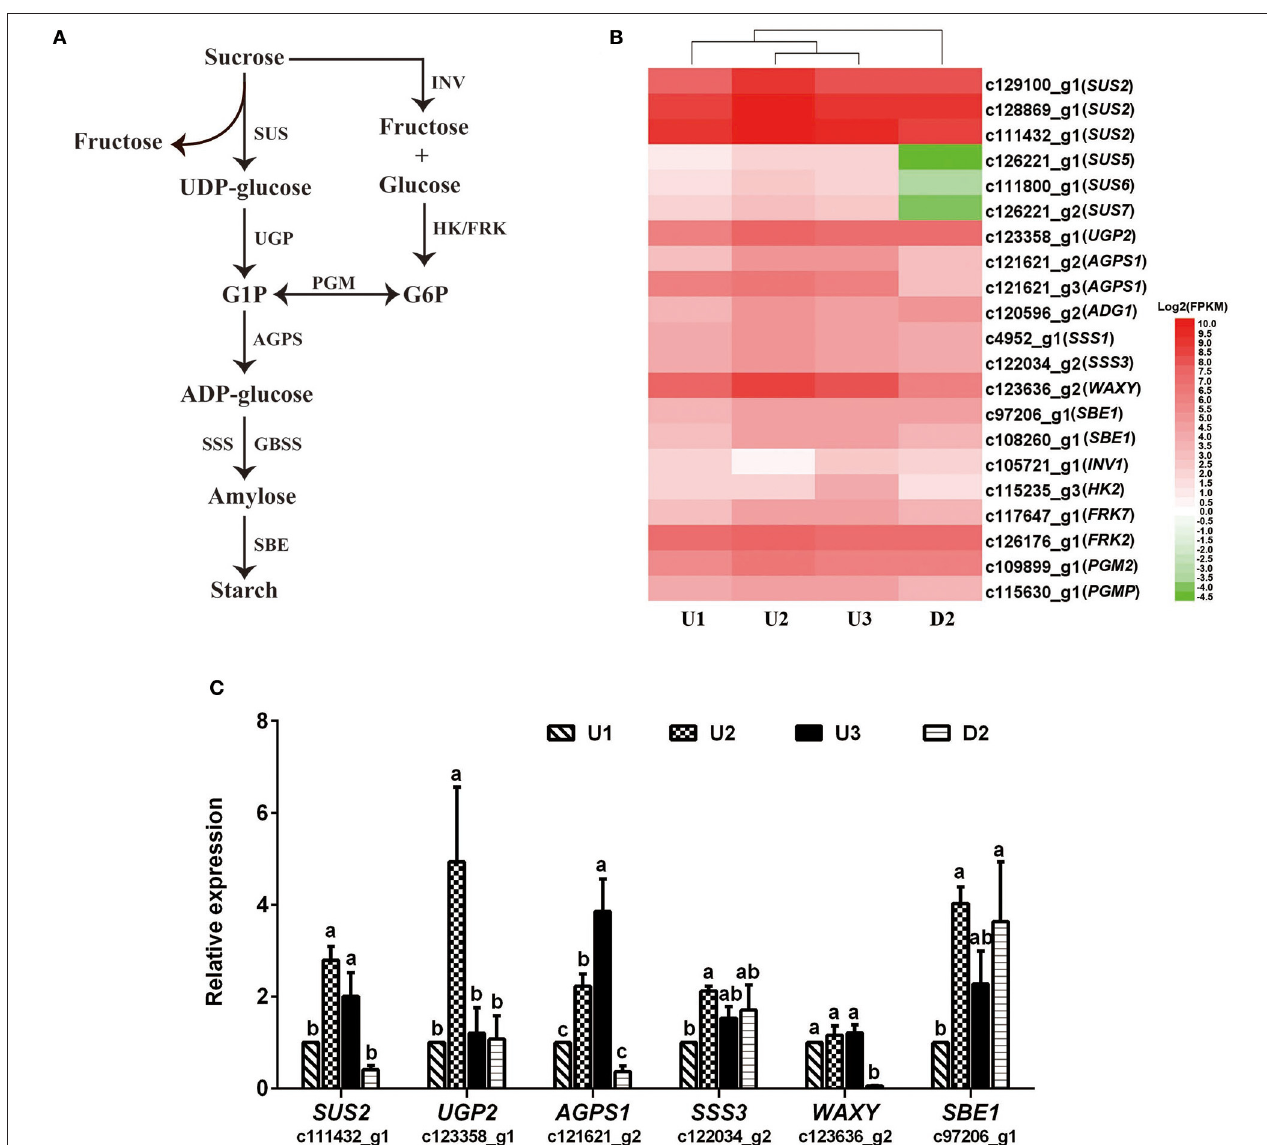
FIGURE 4 | Expression patterns of DEGs assigned to starch biosynthesis and qRT-PCR analysis. (A) The starch biosynthesis pathway shown in this figure was modified from Yang et al. (2015). (B) Heatmap of the expressed genes. The FPKM values of the unigenes were log 2 transformed, and a heatmap was generated using HemI 1.0. Red and green indicate up- and down-regulated transcripts, respectively. SUS, Sucrose synthase; UGP, UTP-glucose-1-phosphate uridylyltransferase; AGPS, glucose-1-phosphate adenylyltransferase; SSS, soluble starch synthase; GBSS, granule-bound starch synthase; SBE, starch branching enzyme; INV, beta-fructofuranosidase; HK, hexokinase; FRK, fructokinase; PGM, phosphoglucomutase. (C) qRT-PCR analysis of the expression profiles of six genes involved in starch biosynthesis. The x-axis represents different samples, and the y-axis shows relative gene expression levels. Columns and error bars indicate means and standard deviations, respectively. Non-overlapping letters (a-c) indicate significant differences ( p < 0.05) between the comparisons of different